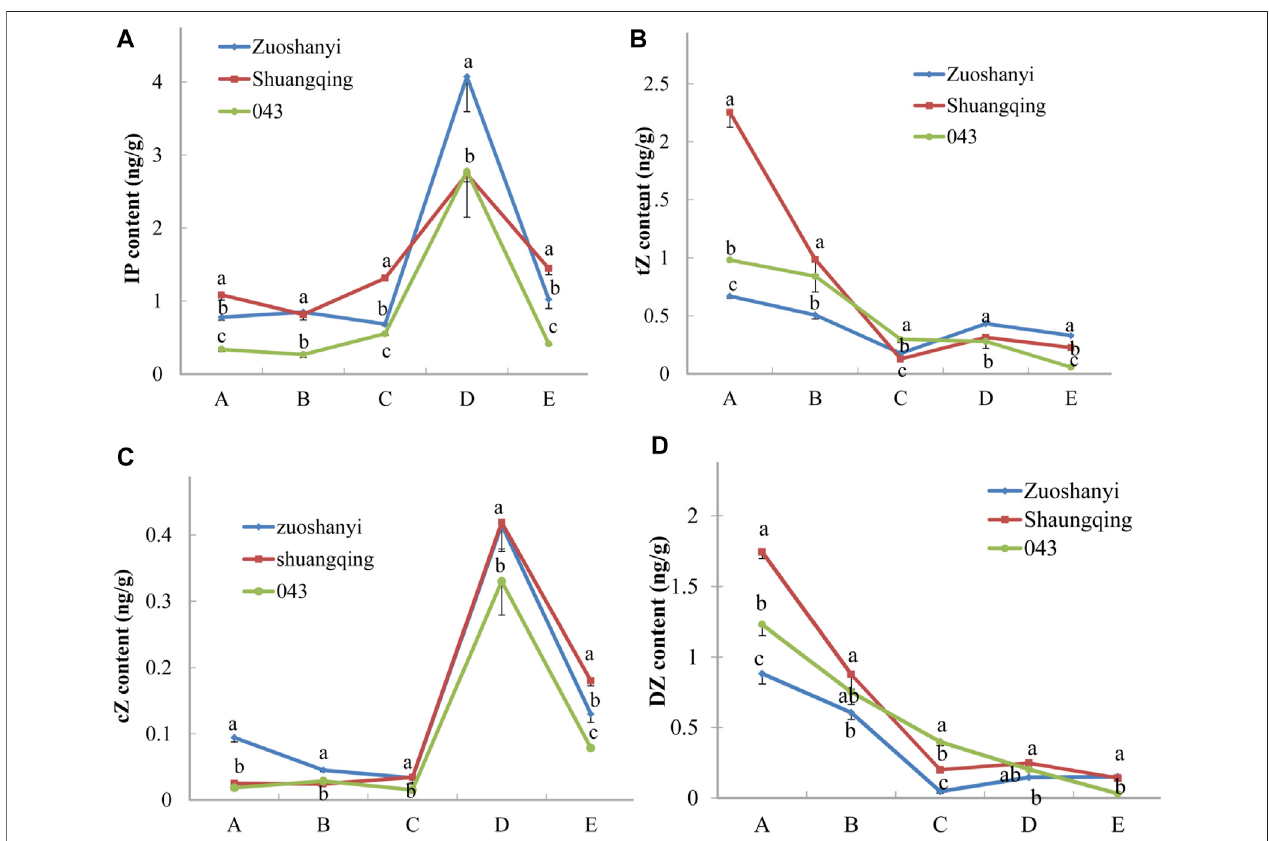
FIGURE 7 | Contents of iP, tZ, cZ, and DZ. Capital letters A to E correspond to the fi ve developmental stages in Figure 1 . Lowercase letters are a marker for the signi fi cant differences at the 0.05 level among three sexes at each single stage.